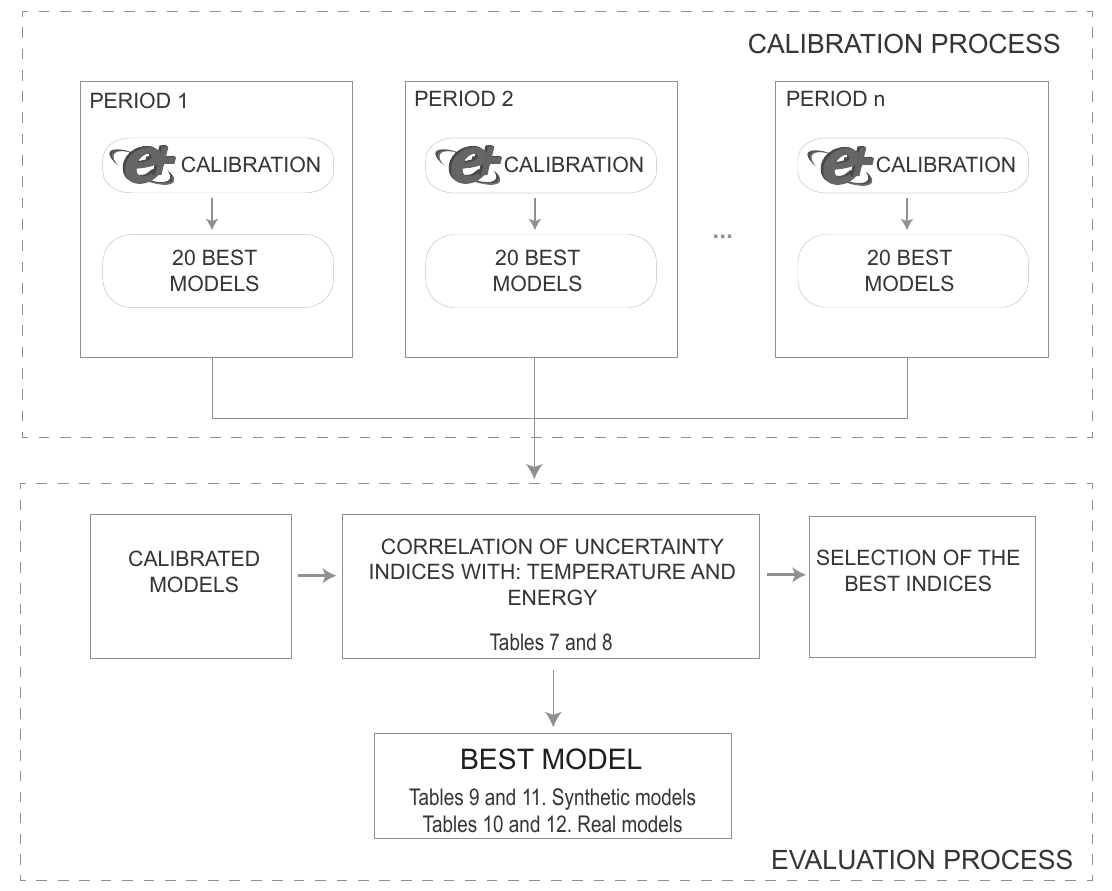
Figure 4. Calibration and evaluation process by ZEC for the different calibration